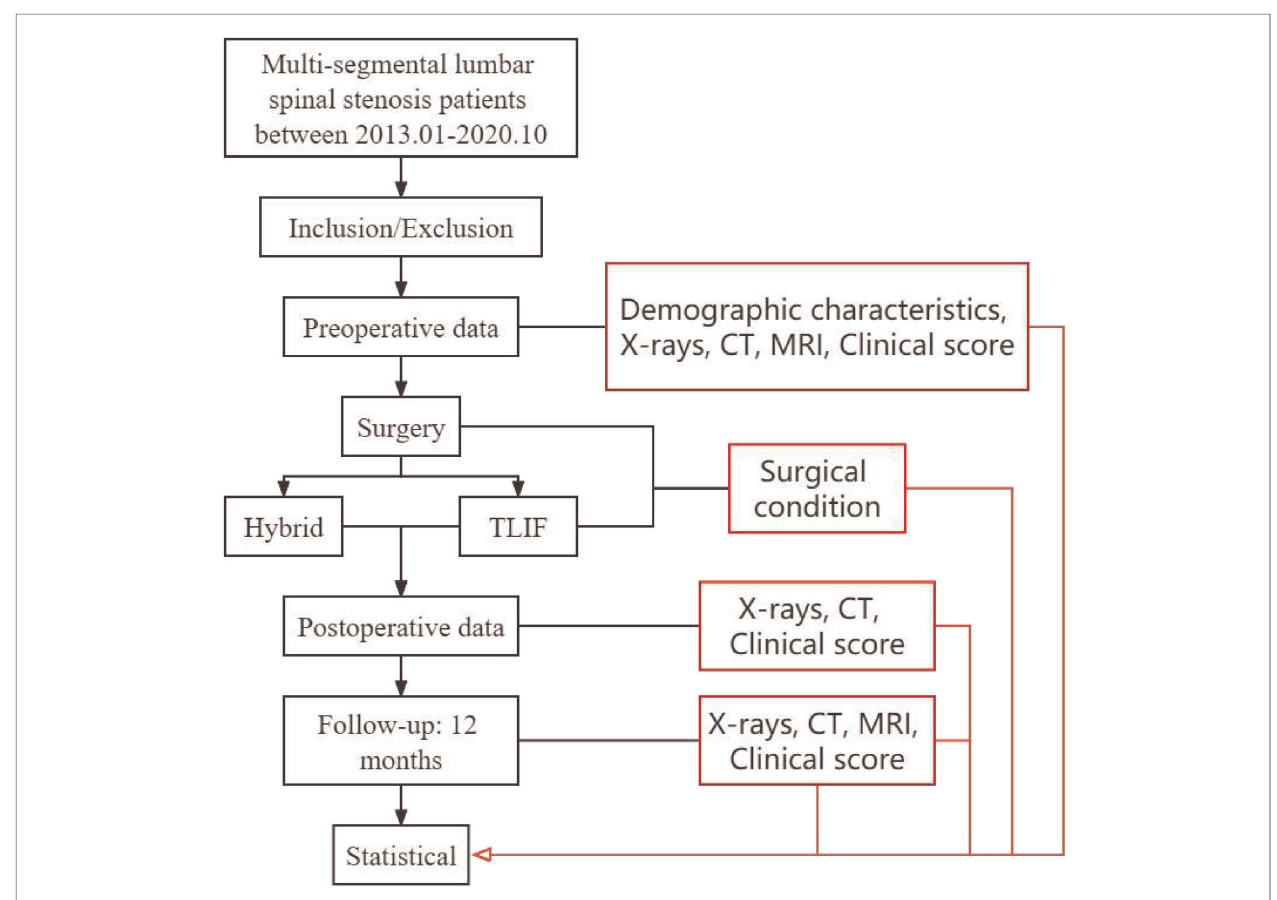
FIGURE 1 | Study fl ow chart. The main objective of the research group was to compare the differences between hybrid surgery and TLIF surgery in the early stage of post-operation and to explore the imaging characteristics in hybrid surgery.